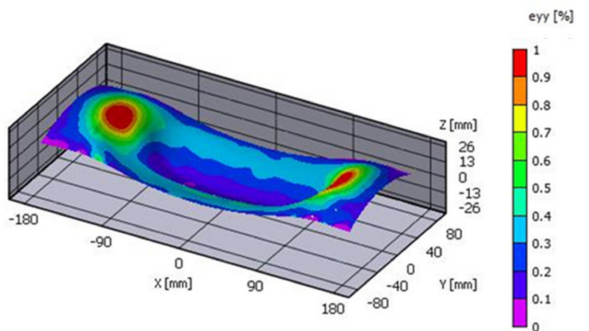
Figure 9. Strain distribution in the y-direction (circumferential) at 6.2 MPa obtained with DIC analysis for Specimen #29.